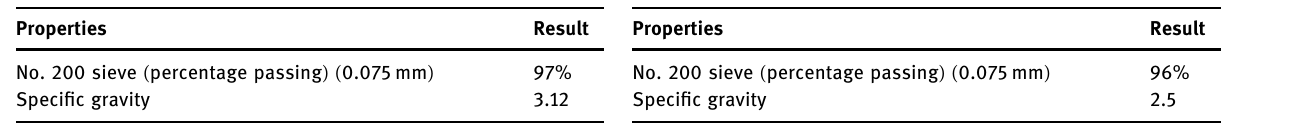
Table 6: Physical characteristics of fl y ash